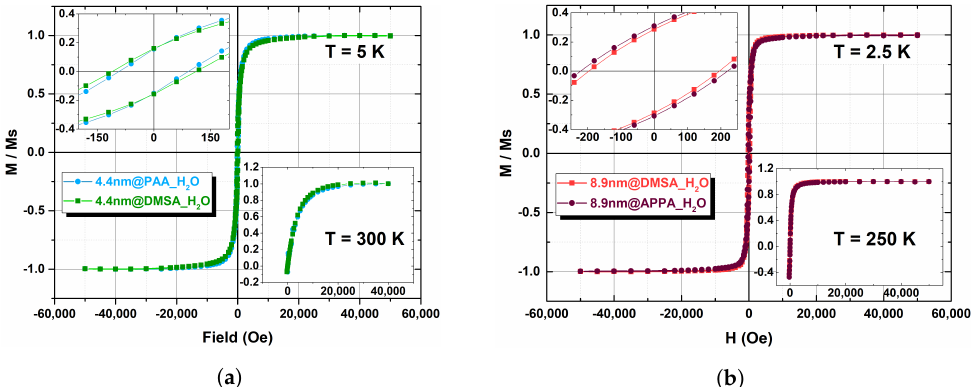
Figure 6. Main figure: hysteresis loops at low temperature of the coated samples of the 4.4 nm set ( a ) and of the 8.9 nm set ( b ), dispersed in water. The insets on the top-left display the detail of the hysteresis at low-field ( M / M S vs. Field (Oe)). Each figure shows in the bottom-right inset the corresponding magnetization curves acquired at high temperature ( M / M S vs. Field (Oe)). Table 2. Saturation magnetization M S of the first and the second set of MNPs powders at low (5 K and 2.5 K for the first and the second set, respectively) and high temperature (300